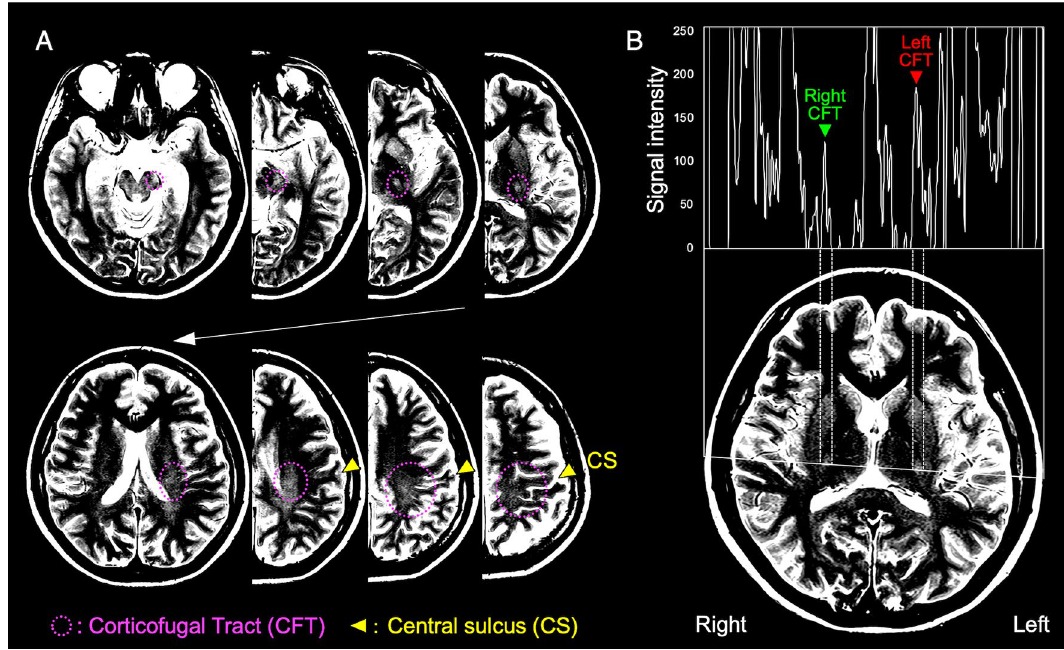
Figure 1. Peak signal intensity of bilateral CFT structures. ( A ) The area identified as CFT had higher signal intensity than the surrounding tissue and was continuous from the cerebral peduncle to the motor related cortex. ( B ) We measured the peak signal intensity values of the CFT structures by plotting the signal intensity of the line segments passing through the center of the bilateral CFT structures as a histogram.